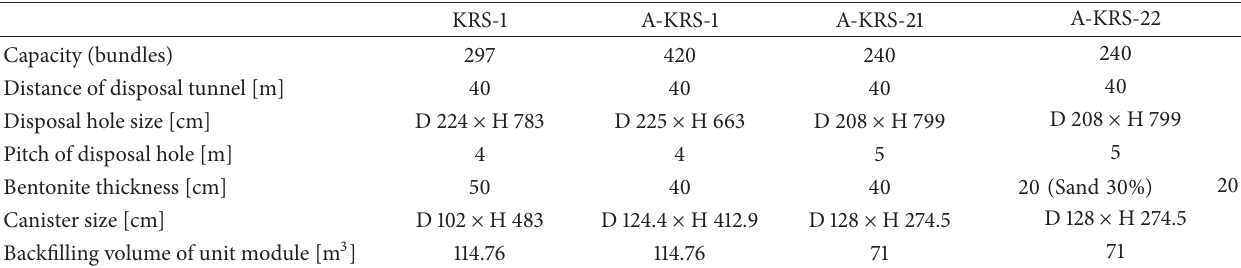
Table 2: The conditions of disposal